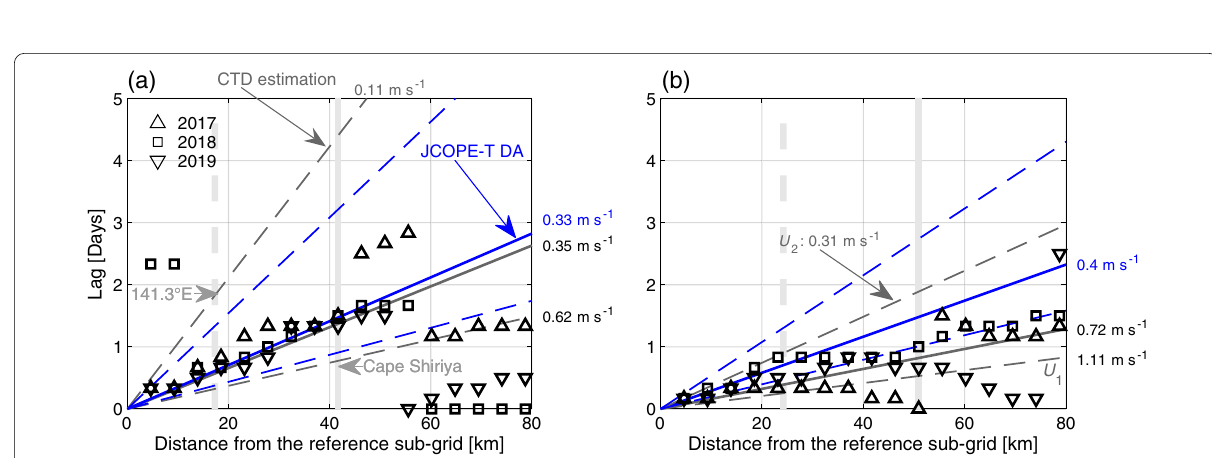
Fig. 13 Distance–lag plot calculated from the high-frequency radar data in a summer and b